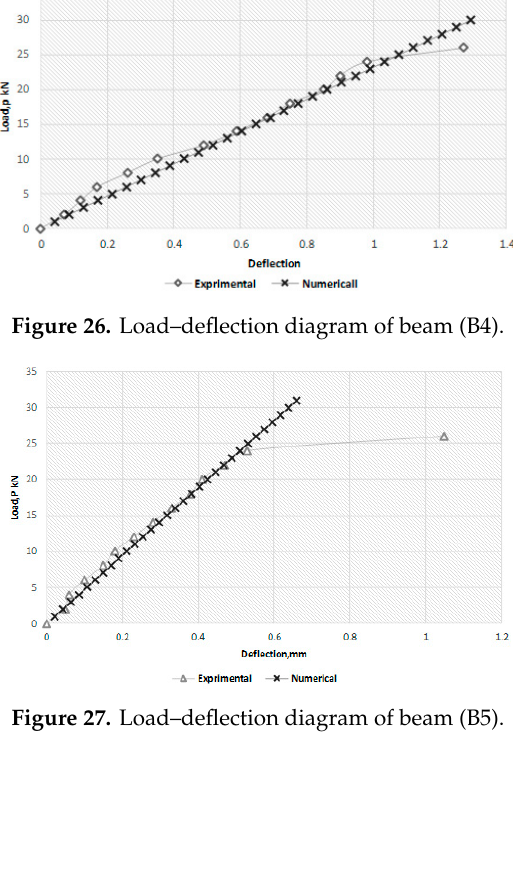
Figure 28. Load–deflection diagram of beam (B6). Figure 29. Load–deflection diagram of beam (B7). 7. Conclusions Based on the experimental program and the numerical study of reinforced concrete beams reinforced with banana fiber bars, the following conclusions can be made: 1.